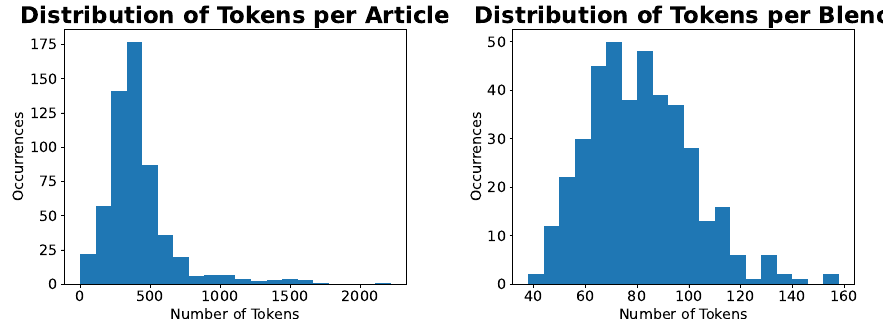
Figure 5. Distribution of the number of tokens in the articles ( left ) and in the blends ( right ). Specifi- cally, the average number of tokens in an article is 418.46, with standard deviation 211.54, whereas, for a blend, the average number of tokens is 85.92, with standard deviation